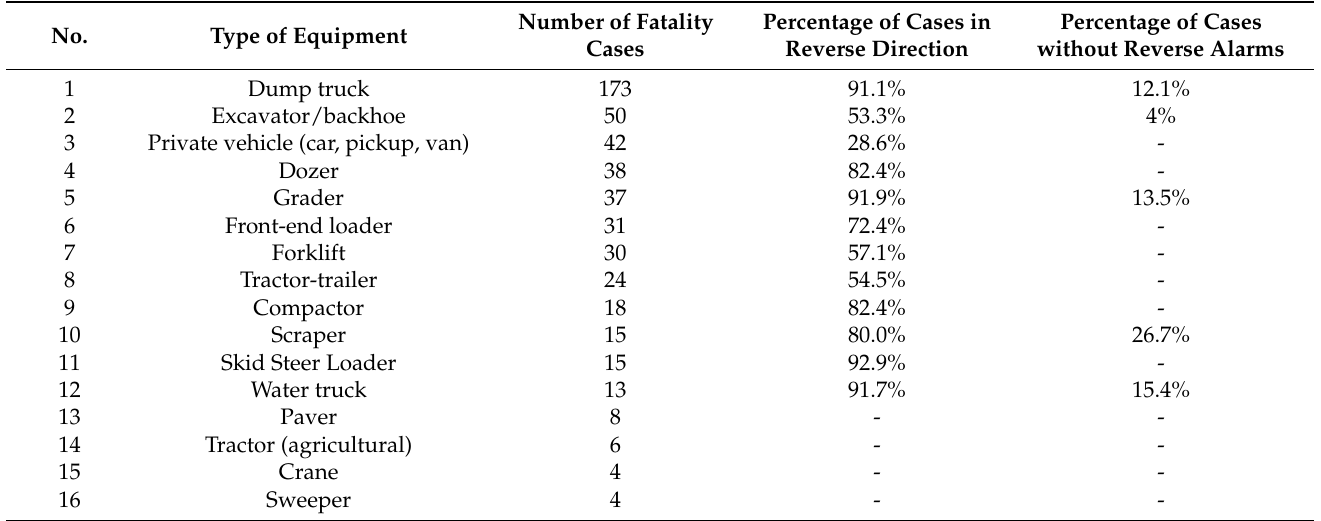
Table 1. Summary of accidents caused by construction equipment between 1990 and 2007 in USA, adopted from